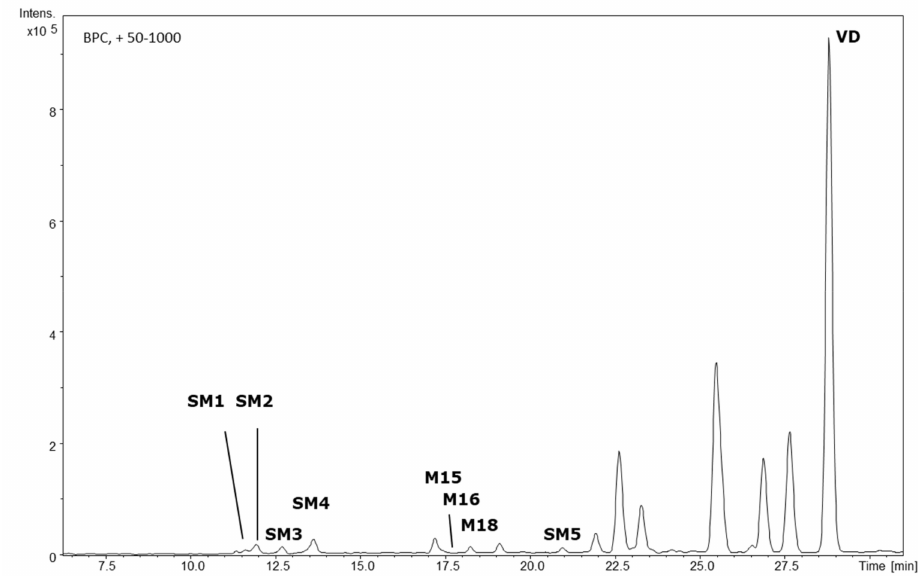
Figure 2. HPLC-QTOF-MS-derived base peak chromatogram of the S9 cell/UGT incubation super- natant featuring the parent compound, vitetrifolin D (VD), and its phase II metabolites SM1–SM5 and additional phase I metabolites. Experimental conditions as given in Figure